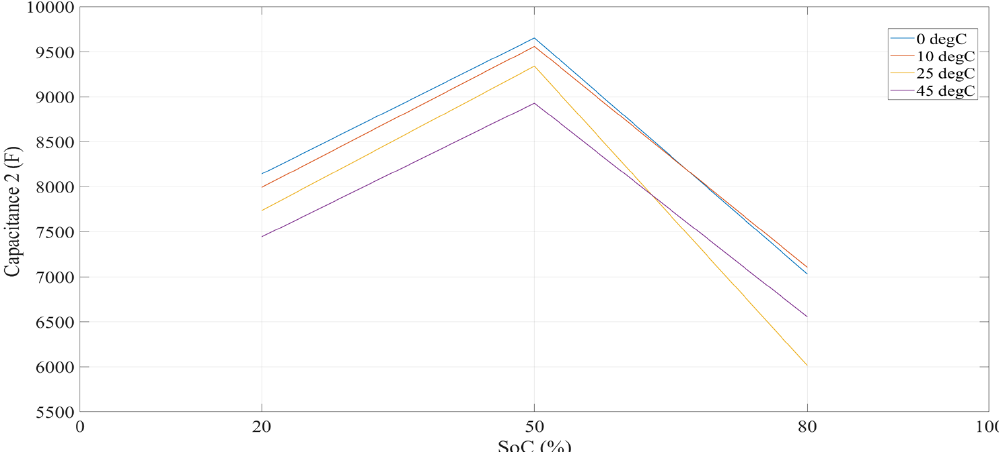
Figure 7. Capacitance 1 as a function of temperature and state of charge.